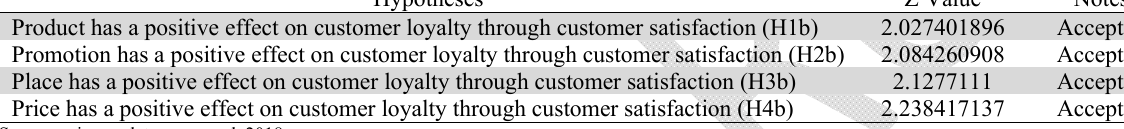
Hypothesis Test of Indirect